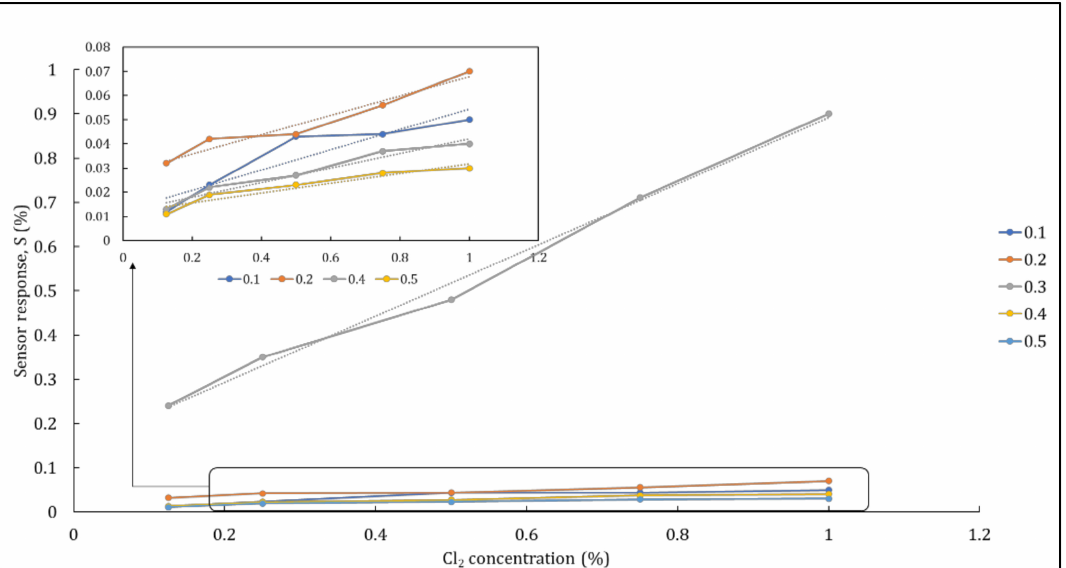
Figure 10. Sensor response of nickel ferrite–nanocellulose nanocomposite towards different chlo- rine